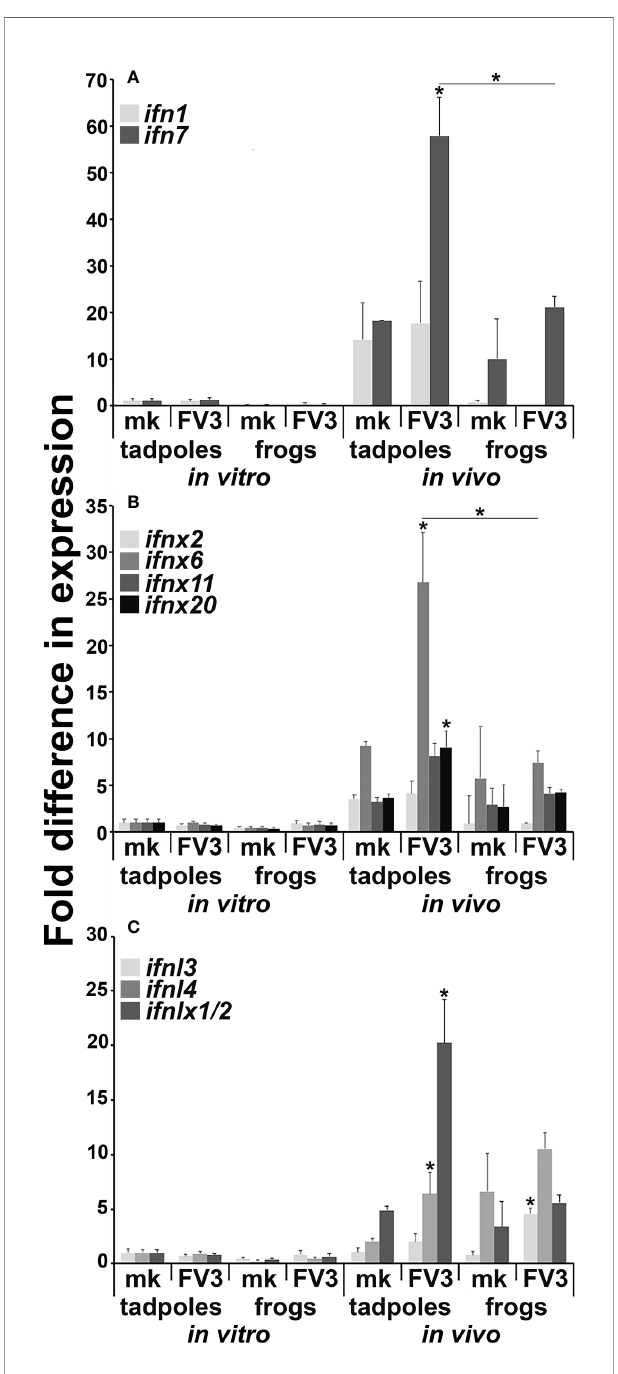
FIGURE 2 | Tadpoles and adult frogs differ in their intestinal antiviral ifn gene expression responses to FV3 infections. Tadpoles ( N =6) and adult frogs ( N =5) were infected by water bath with 10 6 PFU of FV3 for 6 hrs. Alternatively, tadpole and adult intestinal cells ( N =6) were infected in vitro with FV3 (0.5 MOI). The expression of (A) intron-containing ( ifn ) and (B) intronless ( ifnx ) type I IFN genes and (C) type III intron-containing ( ifnl ) and intronless ( ifnlx ) IFN genes was examined relative to gapdh endogenous control. The results are means ± SE of gene expression. Asterisks (*) denote statistical differences between respective in vitro and in vivo expression and asterisks above lines (*) denote statistical differences between the treatment groups denoted by the line, p